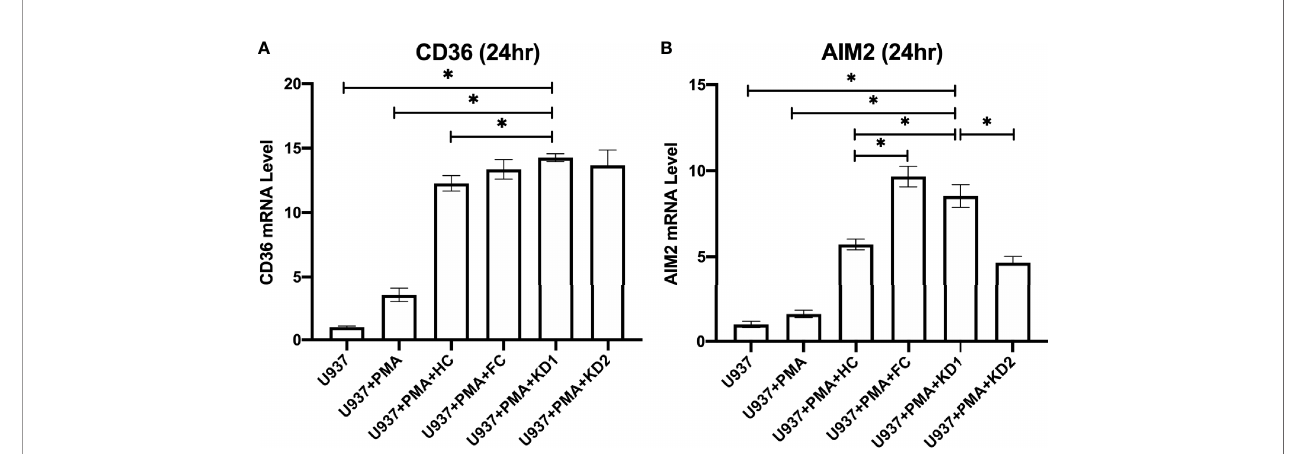
FIGURE 5 | Comparison of relative CD36 and AIM2 mRNA expression in U937-derived macrophages after stimulation with patient plasma. (A) Relative CD36 mRNA expression levels in U937 cell cultures (n=3, mean ± SEM 1 ± 0.08), U937 cells stimulated with PMA (n=3, mean ± SEM 3.49 ± 0.52), U937 cells stimulated with PMA and plasma from healthy patients (n=10, mean ± SEM 12.27 ± 0.59), U937 cells stimulated with PMA and plasma from KD patients 24 hours prior to IVIG therapy (n=10, mean ± SEM 14.26 ± 0.31), and U937 cells stimulated with PMA and plasma from KD patients 21 days after IVIG therapy (n=10, mean ± SEM 13.66 ± 1.19). (B) Relative AIM2 mRNA expression levels in U937 cell cultures (n=3, mean ± SEM 1 ± 0.18), U937 cells stimulated with PMA (n=3, mean ± SEM 1.60 ± 0.22), U937 cells stimulated with PMA and plasma from healthy patients (n=10, mean ± SEM 5.72 ± 0.31), U937 cells stimulated with PMA and plasma from KD patients 24 hours prior to IVIG therapy (n=10, mean ± SEM 8.55 ± 0.65), and U937 cells stimulated with PMA and plasma from KD patients and 21 days after IVIG therapy (n=10, mean ± SEM 4.67 ± 0.36). An asterisk denotes a p-value of less than 0.05. HC, Healthy control; KD1, KD prior to IVIG; KD2, KD after